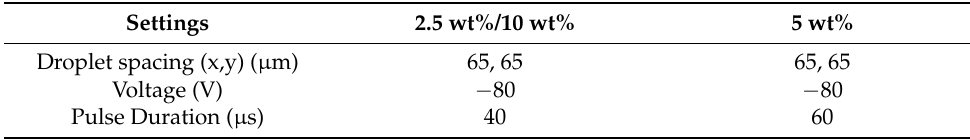
Figure 1. ( a ) Test line structure geometries and top view details from optical microscope for various ink concentrations; ( b ) fabricated devices with a single and multipass approach. Table 1. Printing properties classified by ink concentration.